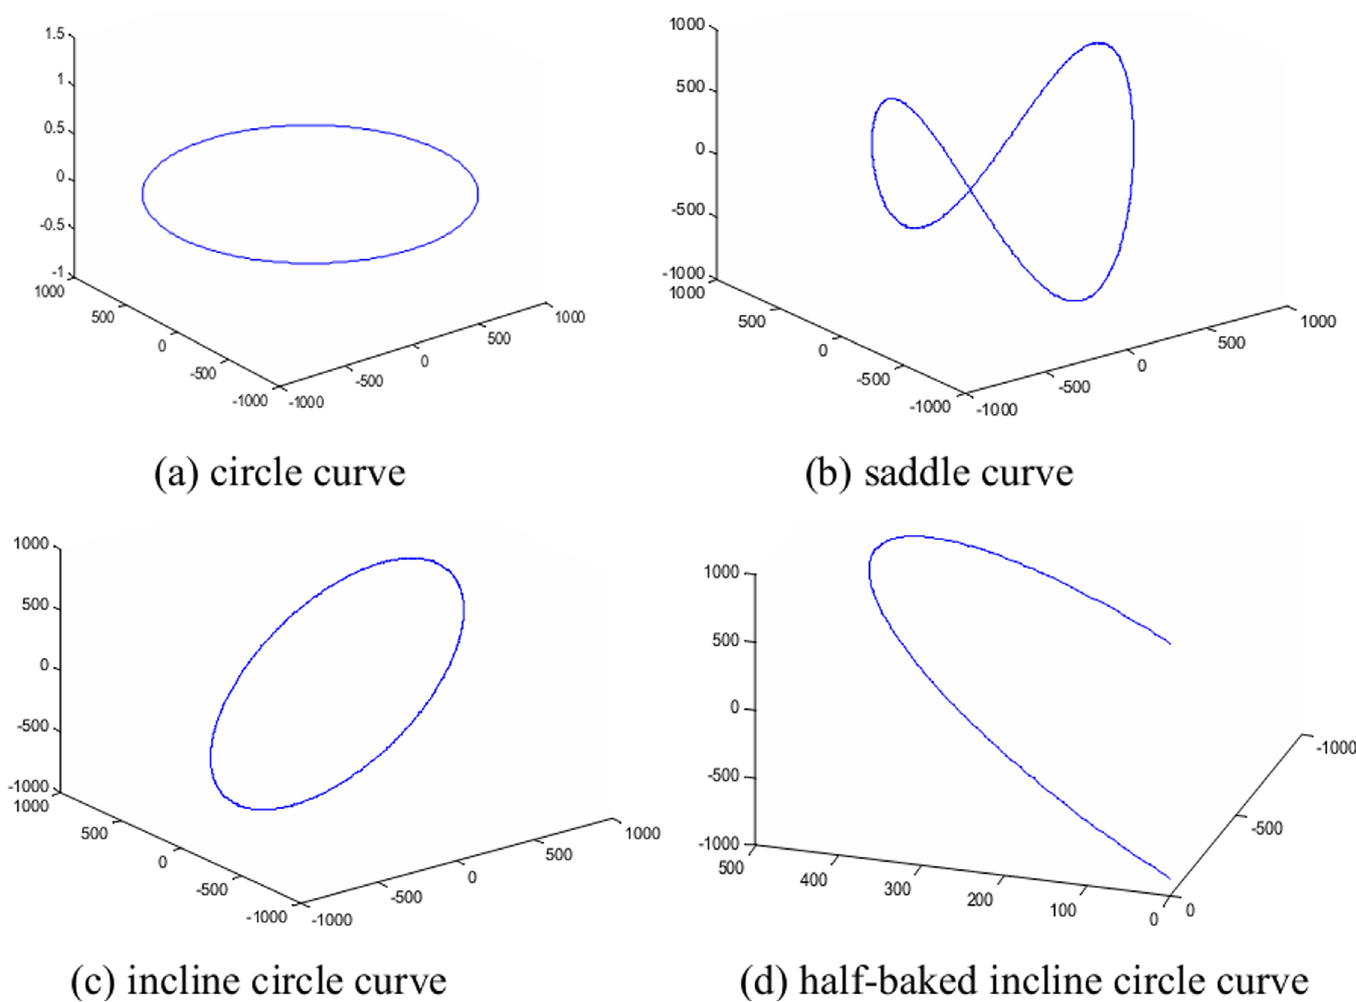
Fig 2. Scanning curves for different parameters on a spherical